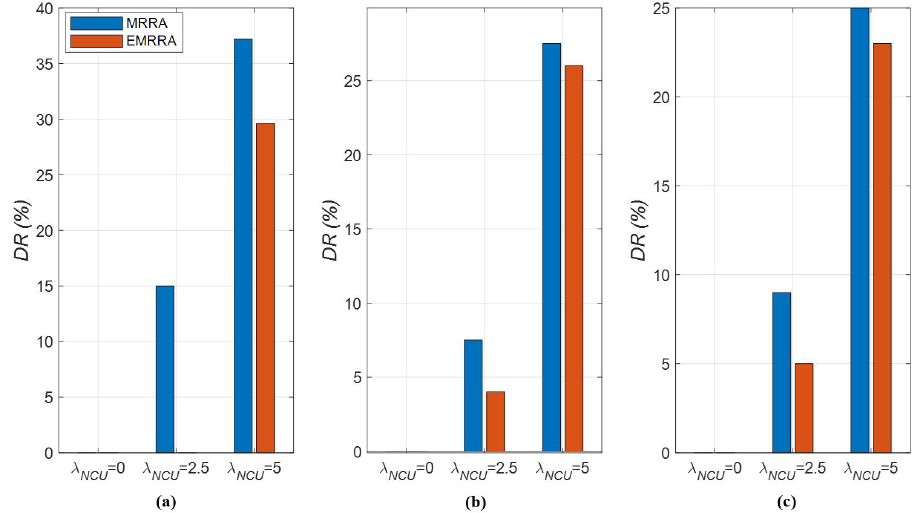
Figure 12. The drop rates of EMRRA and MRRA with respect to λ NCU , K ,and N CU : ( a ) N CU = 10, K = 50; ( b ) N CU = 25, K = 50; ( c ) N CU = 50, K = 50.